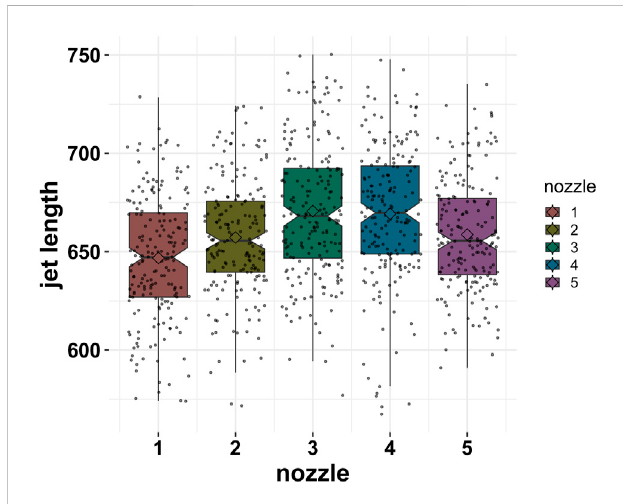
FIGURE 18 Boxplot of experimental results for jet lengths of fi ve cone-shaped nozzles.